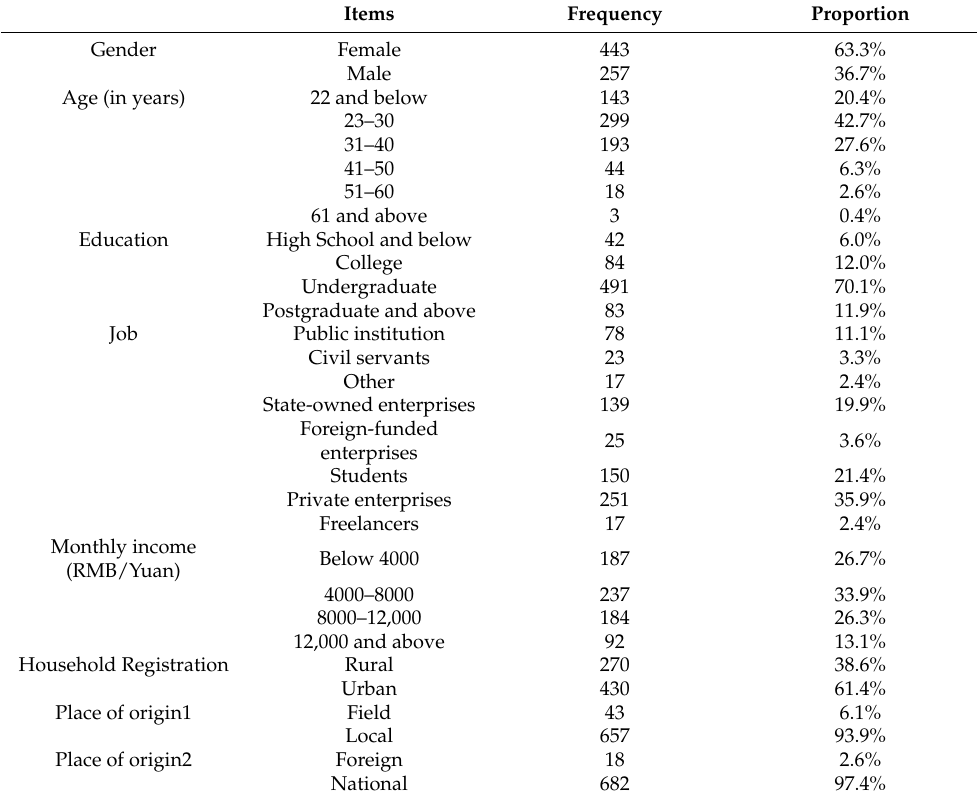
Table 2. Descriptive statistics (N =